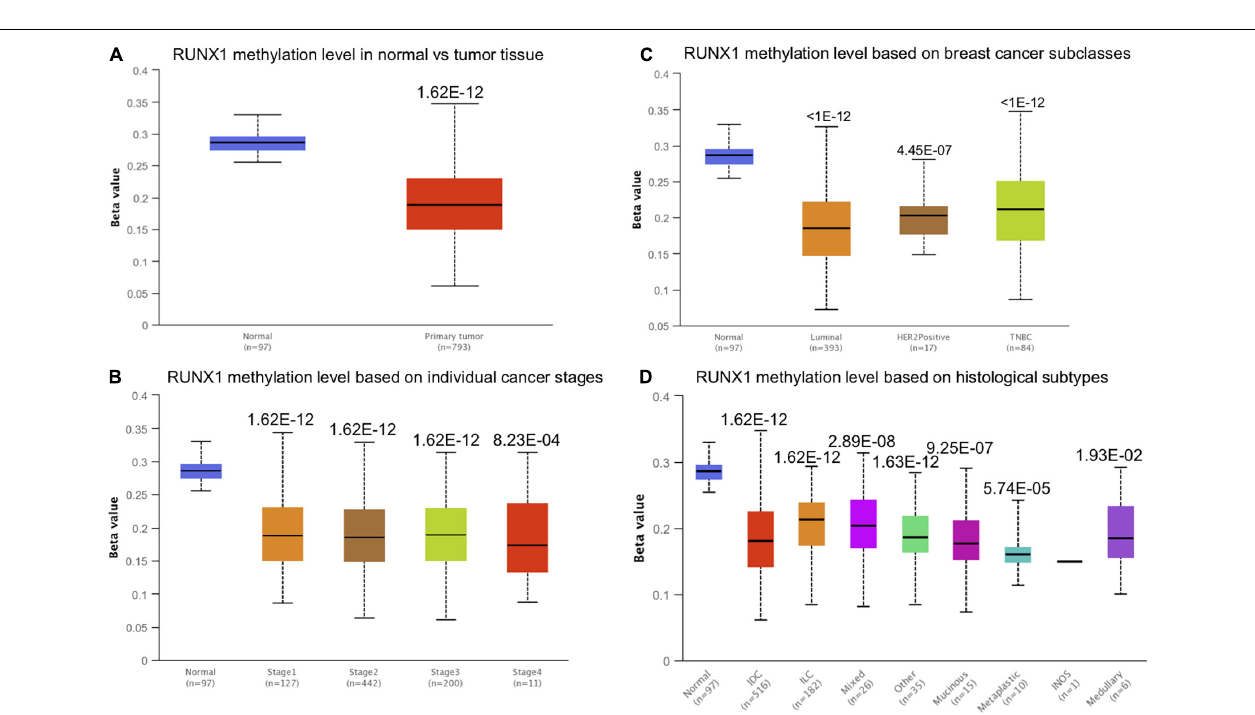
FIGURE 7 | Correlation analysis between RUNX1 methylation level and breast cancer patient characteristics. The RUNX1 methylation level in breast cancer patients classified by (A) sample types, (B) individual cancer stages, (C) breast cancer subclasses, and (D) histological subtypes were shown.